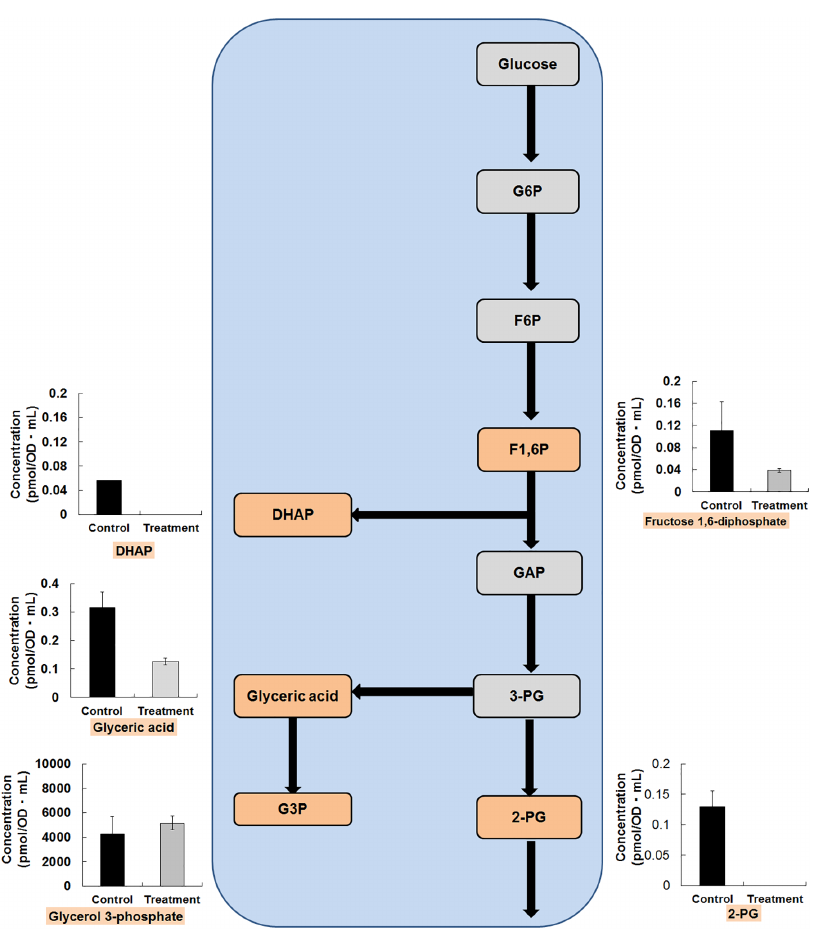
Fig 2. Metabolite changes in the glycolysis pathway by L . plantarum fermentation. Changesin the metabolitelevels of in the fermented O . japonicus by L . plantarum (gray bars) comparedwith those in the O . japonicus with L . plantarum (black bars) were detected by capillaryelectrophoresis time of flight mass spectrometry (CE-TOF-MS). The error bars indicate the mean standard deviationof triplicate samples. The figure also includesa schematic diagram of glycolysis. Abbreviations: G6P, glucose6-phosphate; F6P, fructose 6-phosphate; F1,6P, fructose 1,6-bisphosphate; G3P, glyceraldehyde 3-phosphate;DHAP, dihydroxyacetone phosphate; 3PG, 3-Phosphoglyceric acid; 2PG, 2-Phosphoglycericacid.